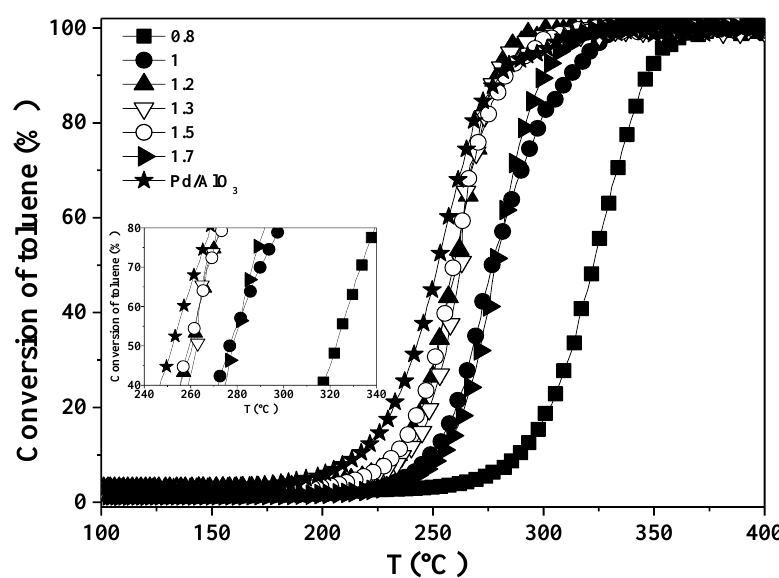
Figure 9. Toluene conversion versus temperature during the second consecutive run (cooling ramp). In the inset, the range of temperature at which conversion values between 40 and 80% were achieved is displayed. The inlet gas composition: 1000 ppm toluene and synthetic air (80/20 vol %) with a total flow of 100 mL × min − 1 and 100 mg of catalyst. Table 4. Catalytic performances of LM catalysts in comparison with Pd (1 wt %)/Al 2 O 3 in terms of temperatures for achieving 10, 50 and 90% of toluene conversion. Data were collected upon cooling. Catalysts